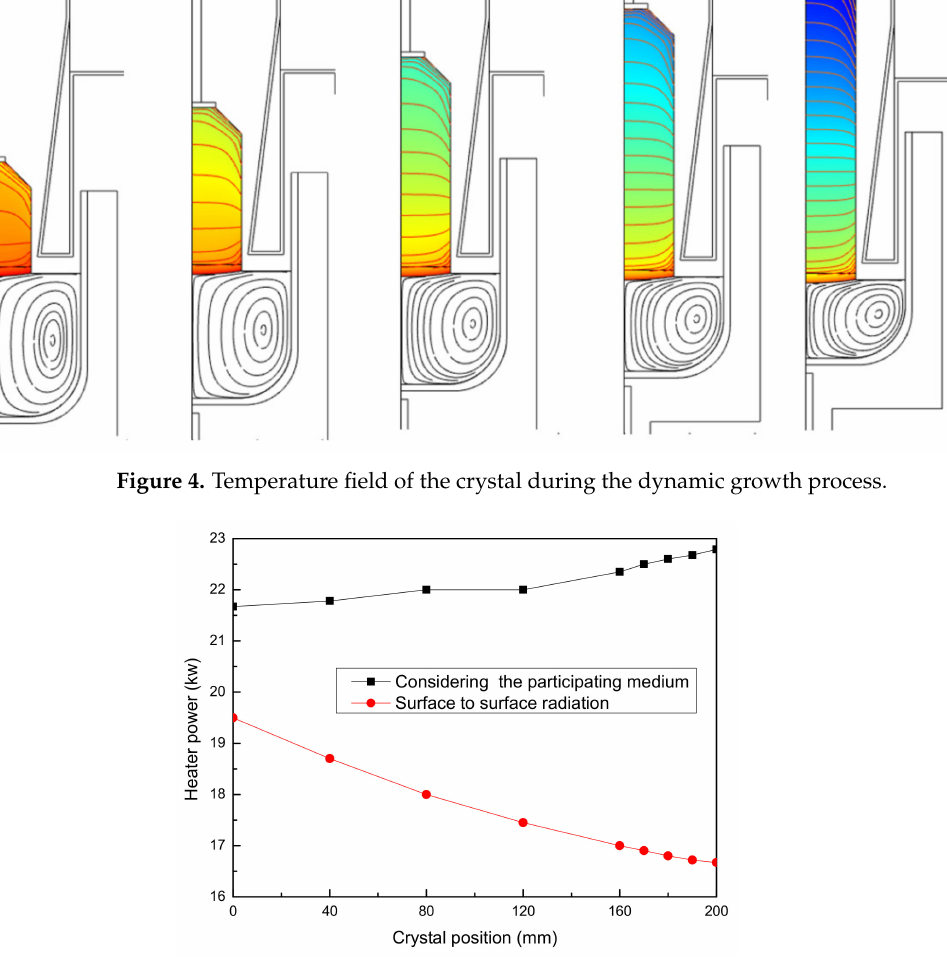
Figure 5. Heater power during the dynamic growth process to help us consider the participating medium and the surface to surface radiation.